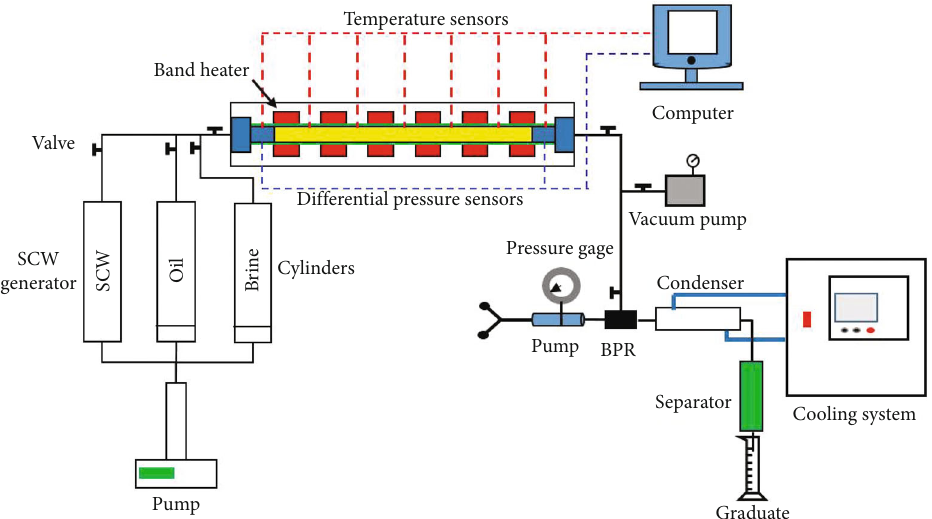
Figure 4: Schematic diagram of the experimental apparatus.